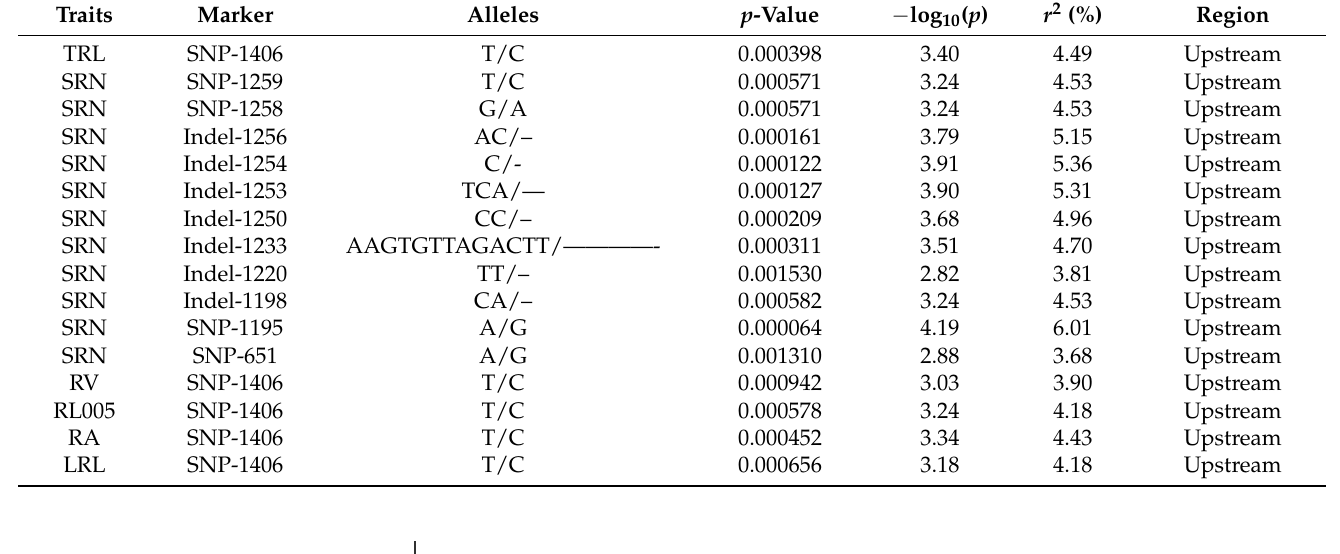
Table 3. Significant markers of ZmCKX5 associated with root traits.